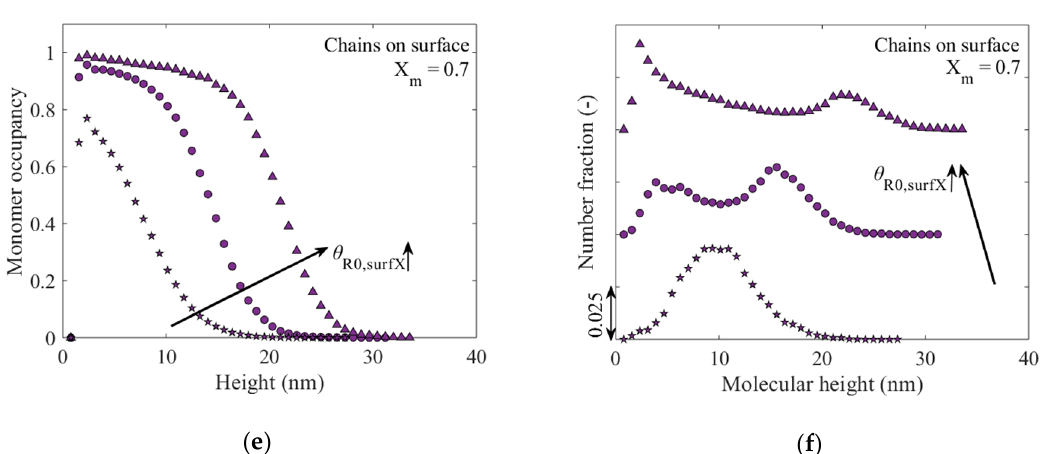
( e ) ( f ) Figure 9. E ff ect of the average RDRP initiator surface coverage ( θ R ) ln ([ M lat ] / [ M lat ] ) vs time, ( b ) the end-group functionality of surface-tethered dormant chains ( EGF surf ) as a function of monomer conversion ( X m ), ( c ) the apparent livingness (definition in Figure 5) of the polymer layer as a function of X m , ( d ) the chain length distribution (CLD) at X m = 0.7, ( e ) the monomer occupancy at X m = 0.7 and ( f ) the molecular height distribution (MHD) at X m = 0.7. Three di ff erent surface coverages are considered: 1.0 × 10 -1 (five-pointed stars), 2.5 × 10 -1 (circles), 5.0 × 10 -1 (upward-pointing triangles); simulation conditions: amount of RDRP initiator molecules N R 0, surf = N R = 1 × 10 5 , target chain length (TCL) of 100 in both phases (initial number of monomer molecules N R 0, lat = 2 × 10 7 ); translational mode.